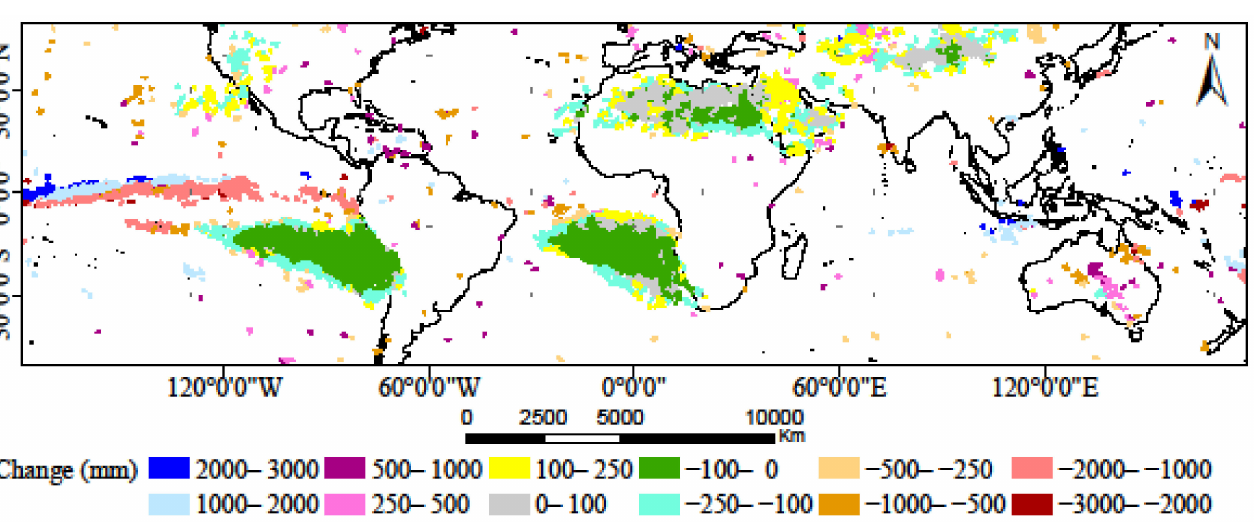
Figure 7. The magnitude of abrupt and non-abrupt changes in the global precipitation time series